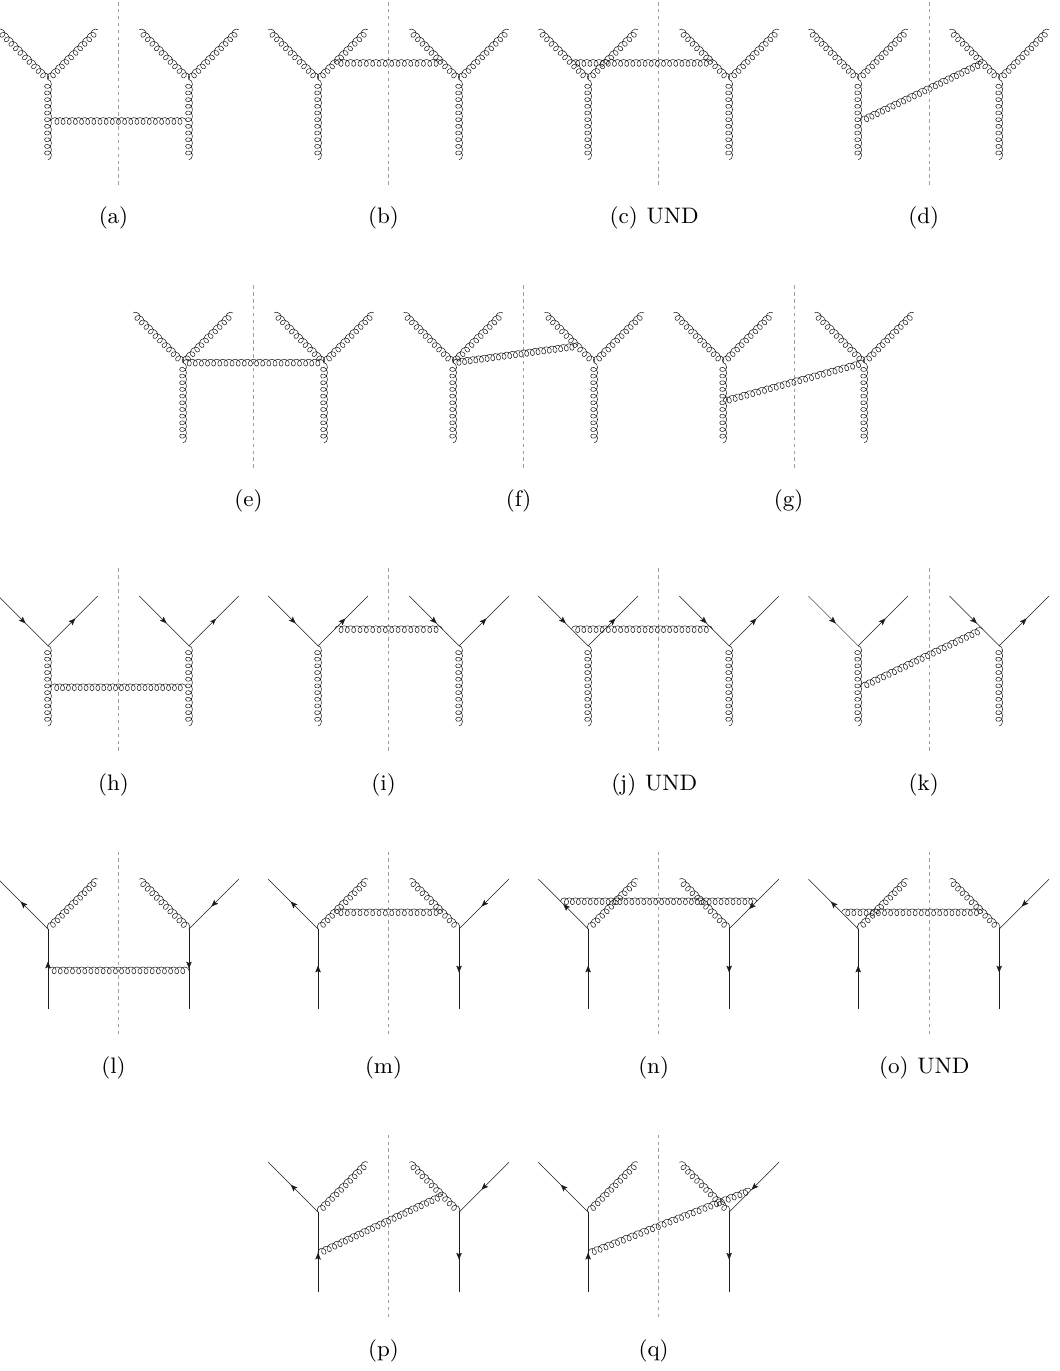
Figure 3 . Real graphs for LO channels. The parton lines at the bottom of the graph correspond to a , and those on top to a , a , a and a from left to right. Additional graphs are obtained 0 1 2 2 1 by interchanging a and by reflection w.r.t. the final state cut. Graphs with topology UND 1 ↔ a 2 (upper non-diagonal) are marked here and further discussed in the